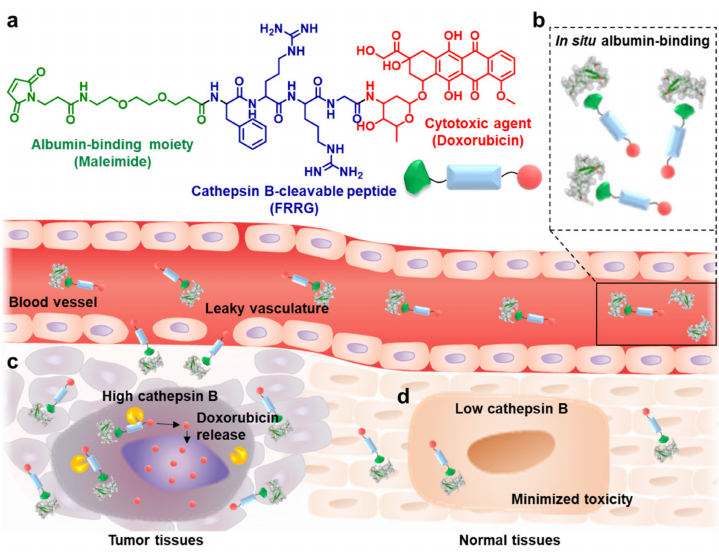
Figure 1. In situ albumin-mediated cancer-targeted therapy by Al-ProD. ( a ) The Al-ProD is pre- pared by conjugating doxorubicin (DOX) to the C-terminus of cathepsin B-cleavable peptide (FRRG) and introducing a maleimide group to the N-terminus of peptide. ( b ) Intravenously injected Al- ProD efficiently binds to in situ circulating albumin in blood vessels. ( c ) Albumin-bound Al-ProD greatly enhances tumor accumulation via albumin-mediated passive tumor targeting and induces a potent antitumor efficacy by selectively releasing free DOX in cathepsin B-overexpressed tumor cells. ( d ) Concurrently, Al-ProD significantly reduced toxicity toward normal tissues with innately low cathepsin B expression by maintaining a non-toxic inactive state, thereby increasing the safety of chemotherapy.